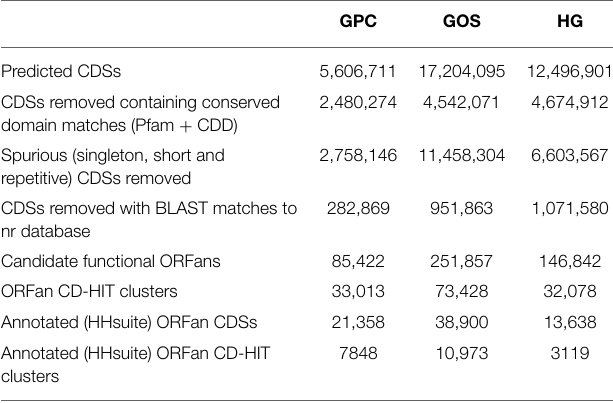
TABLE 2 | Average G + C content and length of domain-annotated vs. ORFan sequences from three